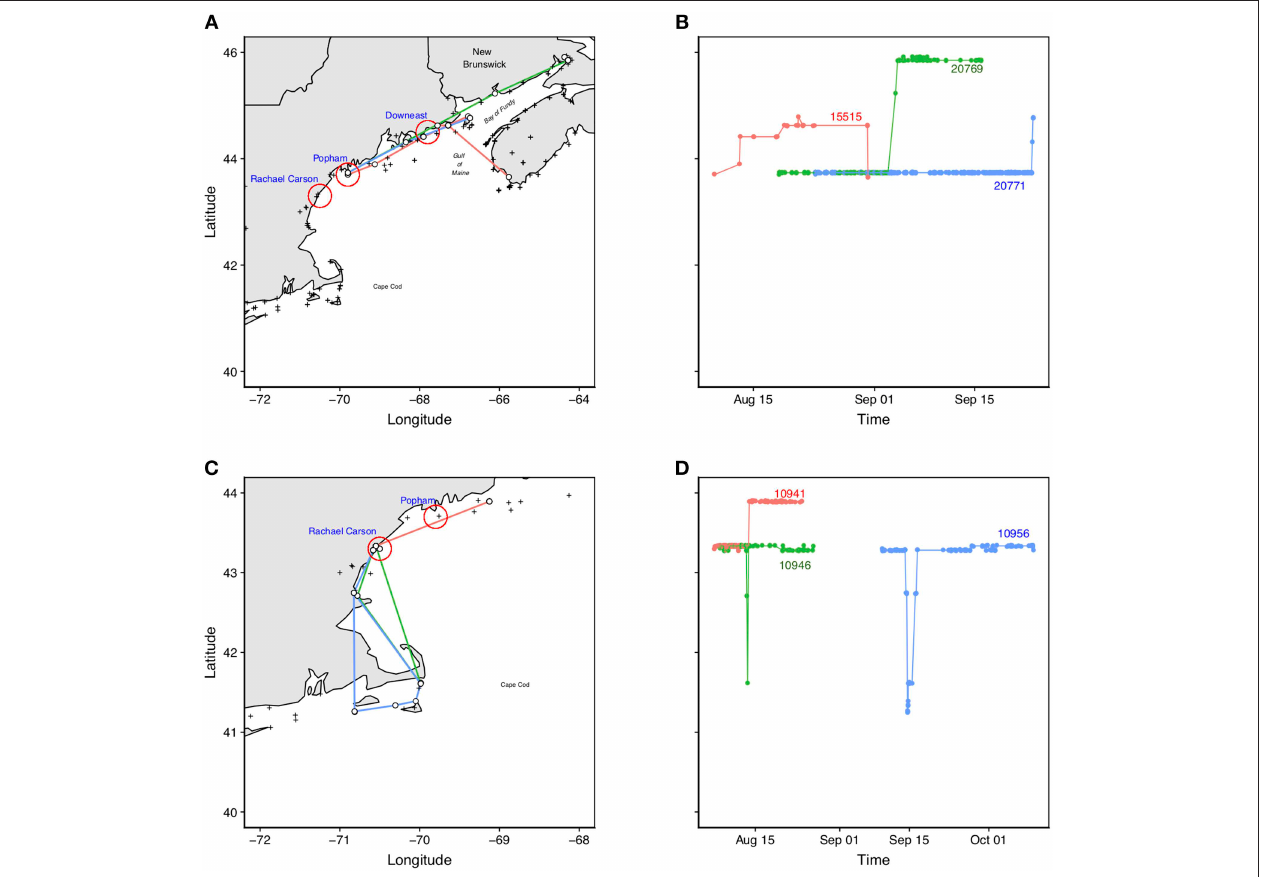
FIGURE 5 | Examples of movements of individual Semipalmated Sandpipers (noted by Motus ID#) tagged at Popham Beach (A,B) and Rachel Carson NWR (C,D) . The panels on the left hand side (A,C) show the pathways of the birds within the region; panels on the right hand side (B,D) show the latitudinal movements of the same birds through time. Birds tagged at Popham: bird Motus #20769 (green) moved northeast to the upper part of the Bay of Fundy; bird Motus #15515 (red) moved northward and was last detected at the southwest coast of Nova Scotia; bird Motus #20771 (blue) moved northward and was last detected at Grand Manan Island. Birds tagged at Rachael Carson: Two birds, Motus #10956 (blue) and #10946 (green) made forays south to the Cape Cod area before returning to Rachel Carson NWR where they were both last detected; bird Motus#10941 (red) moved northward and was last detected at the mouth of the Bay of Fundy. These patterns collectively reveal the connectivity among areas in the Bay of Fundy, the Gulf of Maine, and southern New